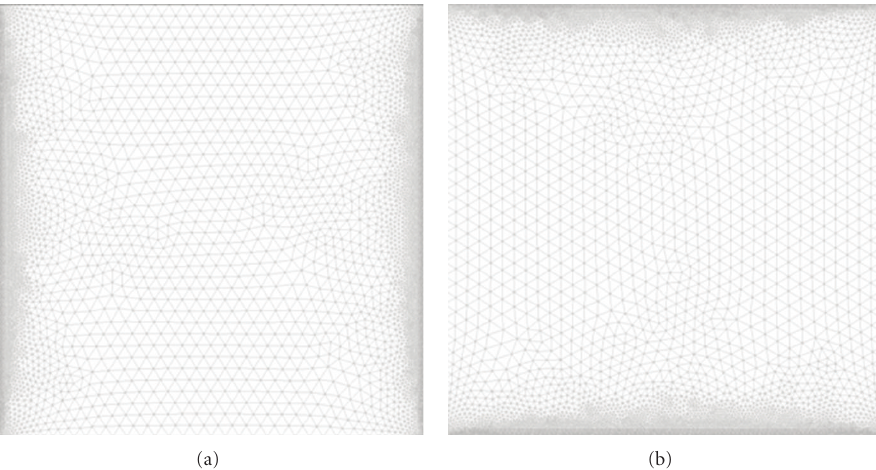
Figure 2: (a) Mesh distributions for the 2D dimensional Cases A. (b) Mesh distributions for the 2D dimensional Cases B and C